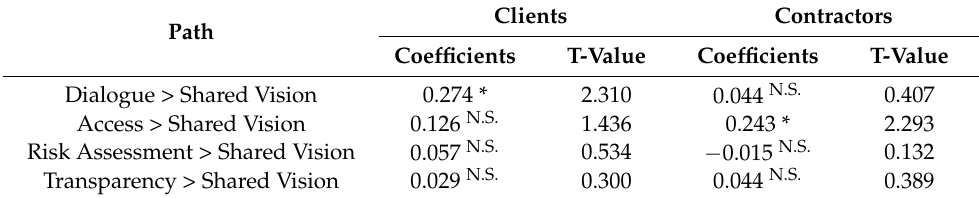
Table 4. Results of individual perspectives.